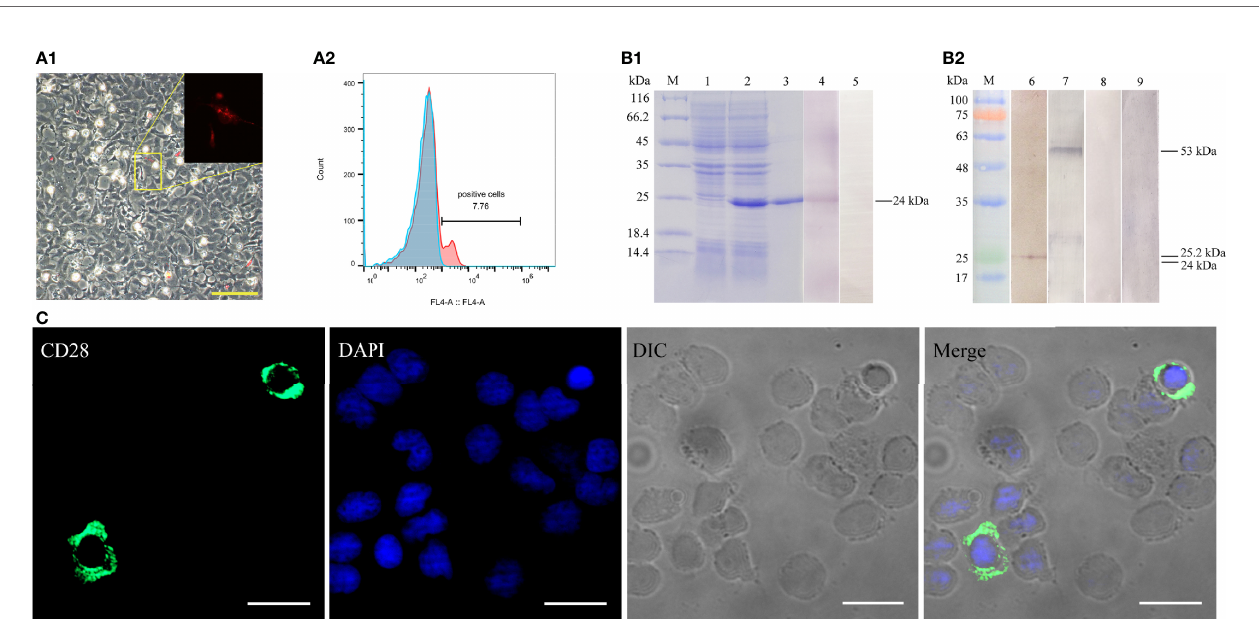
FIGURE 3 | Veri fi cation of the speci fi city of the prepared antibodies. (A) Detection of CD28 expression in transfected HINAE cells. A1, The red signal means that HINAE transfected with pTagRFP-N-CD28 plasmid successfully expressed the recombinant protein. Scale bar = 50 m m. A2, Flow cytometric analysis of the percentage of cells expressing CD28 after transfection. (B) Western blotting analysis of anti-CD28 rabbit polyclonal antibody speci fi city. Lane M, molecular mass marker; lane 1, transformed E. coli without IPTG induction; lane 2, transformed E. coli induced with IPTG; lane 3-5, puri fi ed recombinant CD28 protein (24 kDa); lanes 6 and 8, whole-cell protein extracts from PBLs; lanes 7 and 9, whole-cell protein extracts from HINAE cells transfected with pTagRFP-N-CD28 vector. (C) Subcellular localization of CD28 on PBLs. CD28 molecule mainly located on the cell surface. Scale bar =10 m